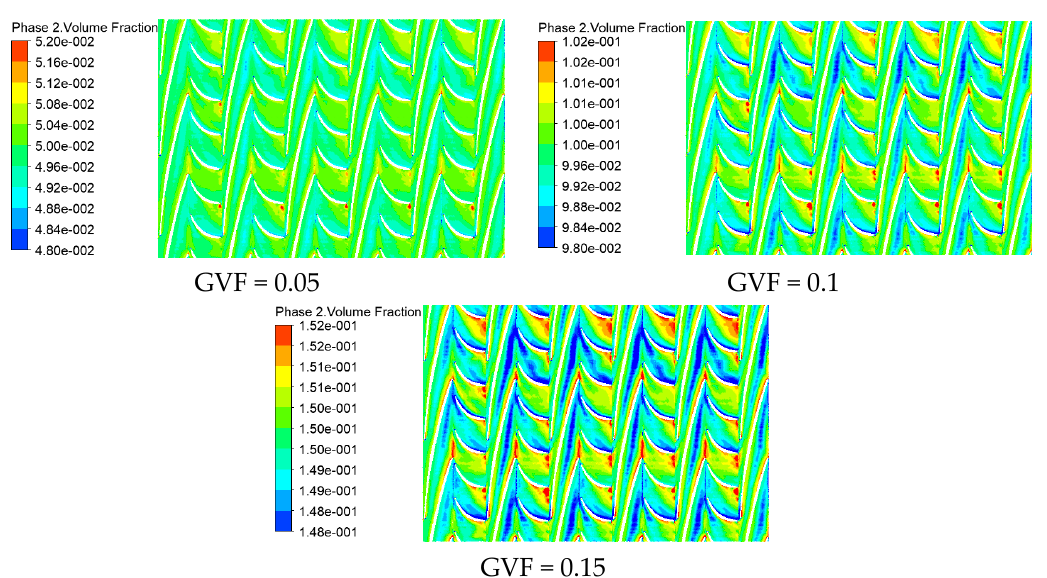
Figure 9. The gas-phase volume distribution in the pressurization unit at 0.8 times the height of the blade at different GVFs.